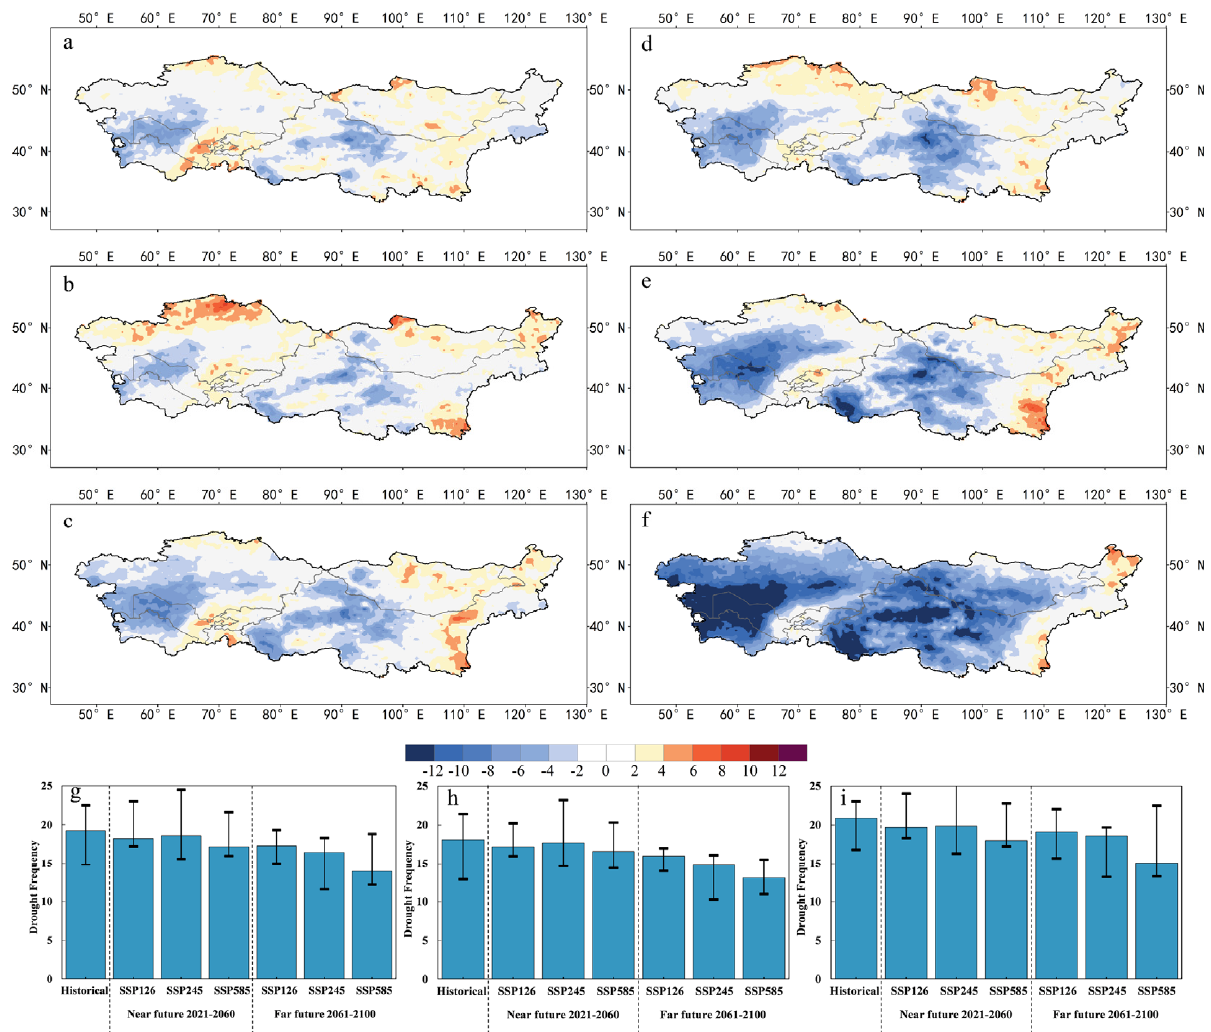
Figure 6. Spatial distribution of Asian dryland RADF for the cycles 2021–2060 ( a , b , c ) and 2061–2100 ( c , d , f ) under the SSP126 ( a , d ), SSP245 ( b , e ) and SSP585 ( c , f ) scenarios, relative to the 1961–2000 reference cycle. Changes in drought frequency as identified by the SPEI drought index for 2021–2100. Drought frequency changes ( g ) in the drylands of Asia for 2021–2060 and 2061–2100 under the SSP126, SSP245, and SSP585 scenarios. Two regions ( i ) in northwest China and Mongolia and ( h ) in the five Central Asian countries are delineated. The bar graphs and black vertical lines indicate the mean and range of multiple GCM